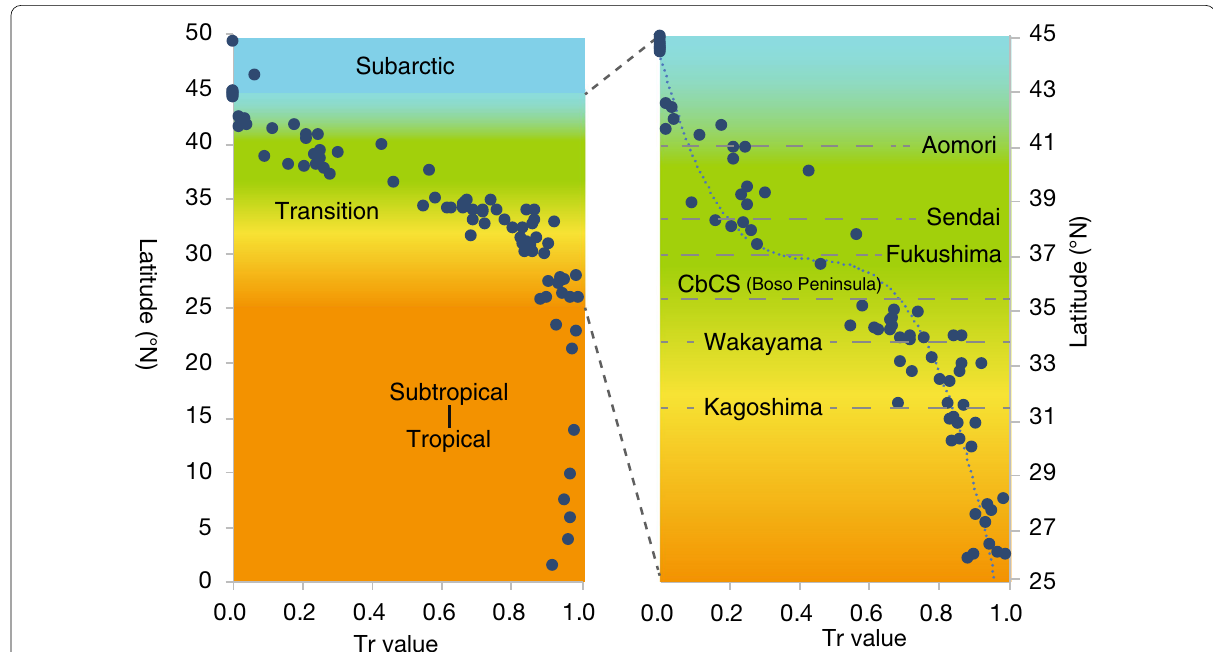
Fig. 2 Plot showing the latitudinal distribution of Tr values in the northwestern Pacific based on the dataset from Matsuzaki and Itaki (2017). Similar plots for each species or species groups used for the Tr estimation are shown in Additional file 5: Fig.